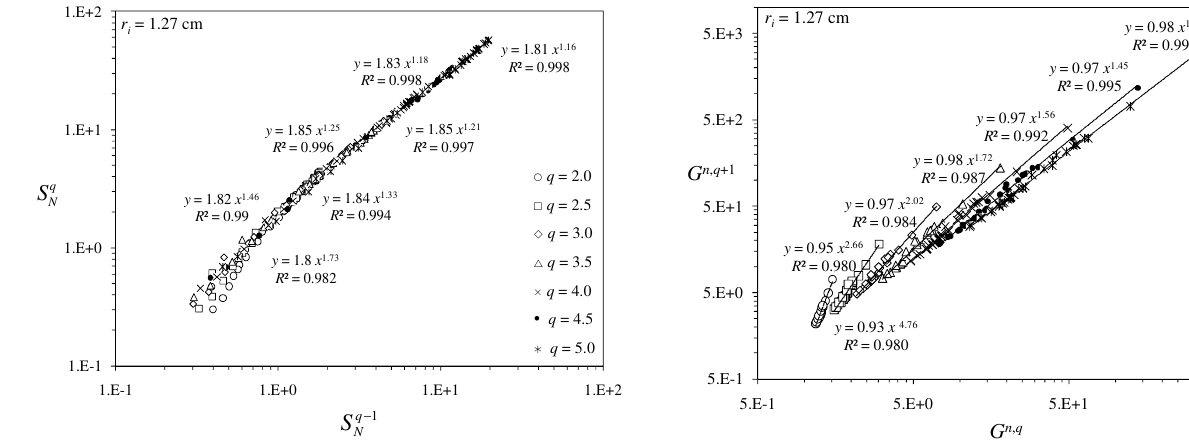
− 1 Fig. 6. S q versus S q for 2.0 ≤ q ≤ 5.0 and r i =1.27cm evaluated N N on face 1 along x-axis. Linear regression equations and relative regression coefficients ( R 2 ) are also reported.